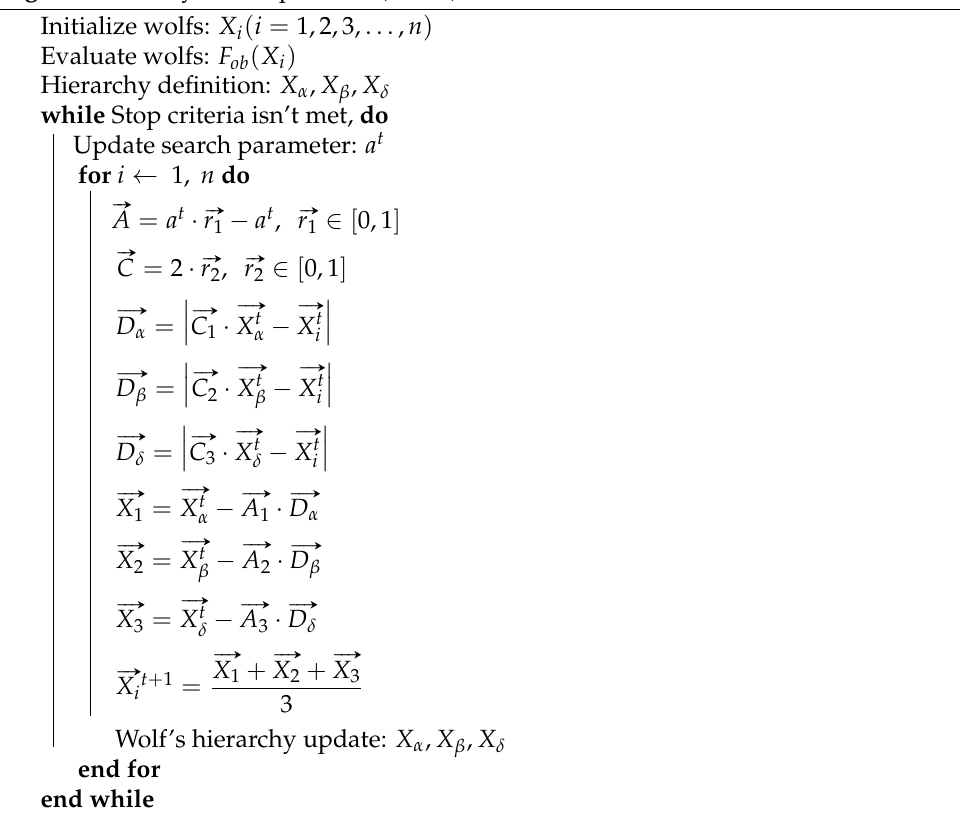
Algorithm 2 Grey Wolf Optimizer (GWO)